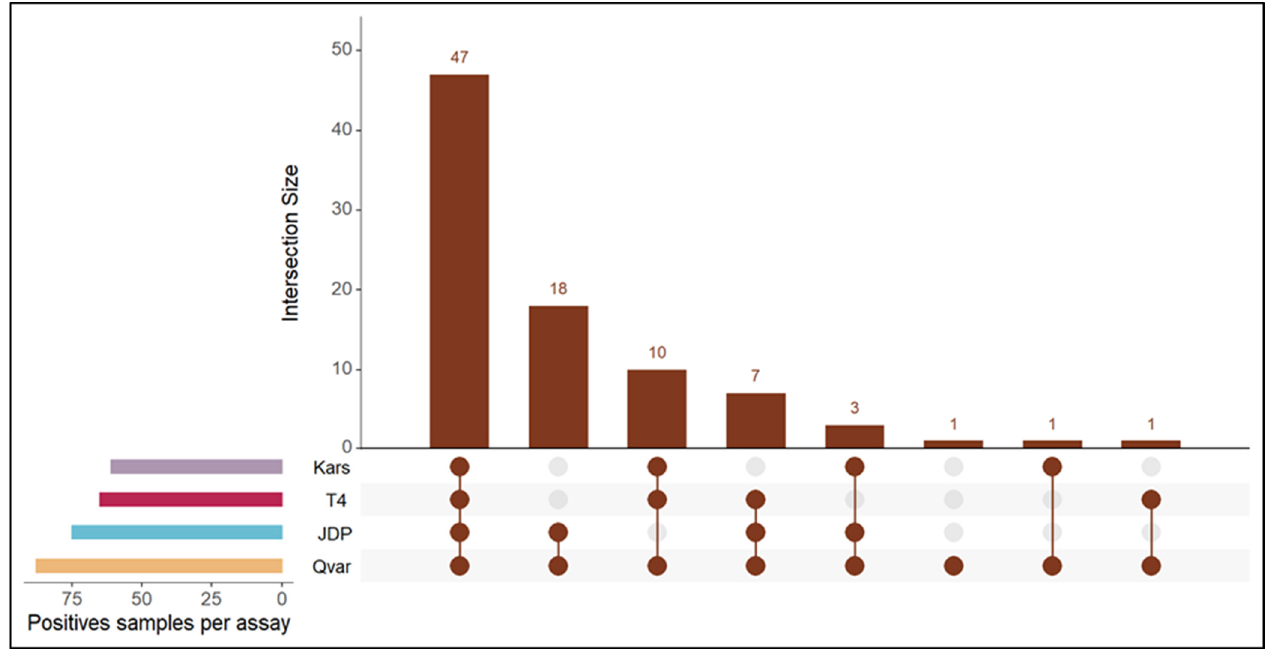
Figure 2. Upset graph of the assays presenting the size of the intersections (cardinality) of the pos- itive samples with JDP (turquoise), Qvar (orange), Kars (purple), and T4 (red) assays. The JDP PCR products of three non-T4 samples were sequenced and confirmed to be T11 (1 sample) and T3 (2 samples). T11 (1 sample) and T3 (2